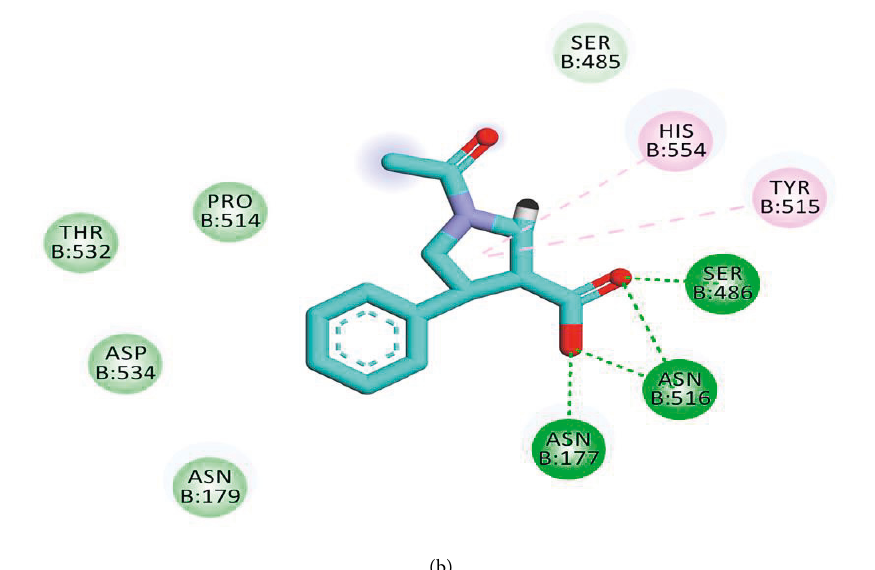
Figure 5: (a) 3D and (b) 2D of VXG docked into the active site of SARS-CoV-2 helicase.